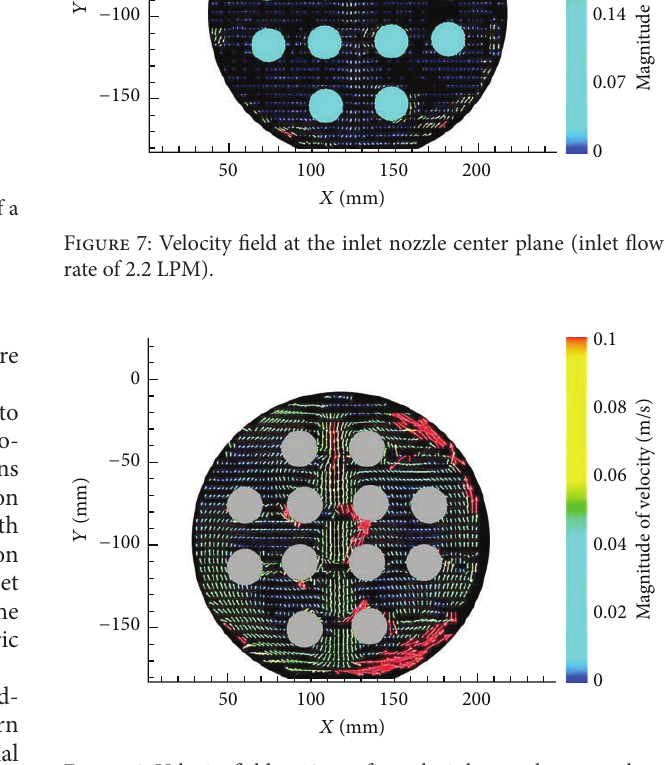
Figure 8: Velocity field at 40 mm from the inlet nozzle center plane (inlet flow rate of 2.2